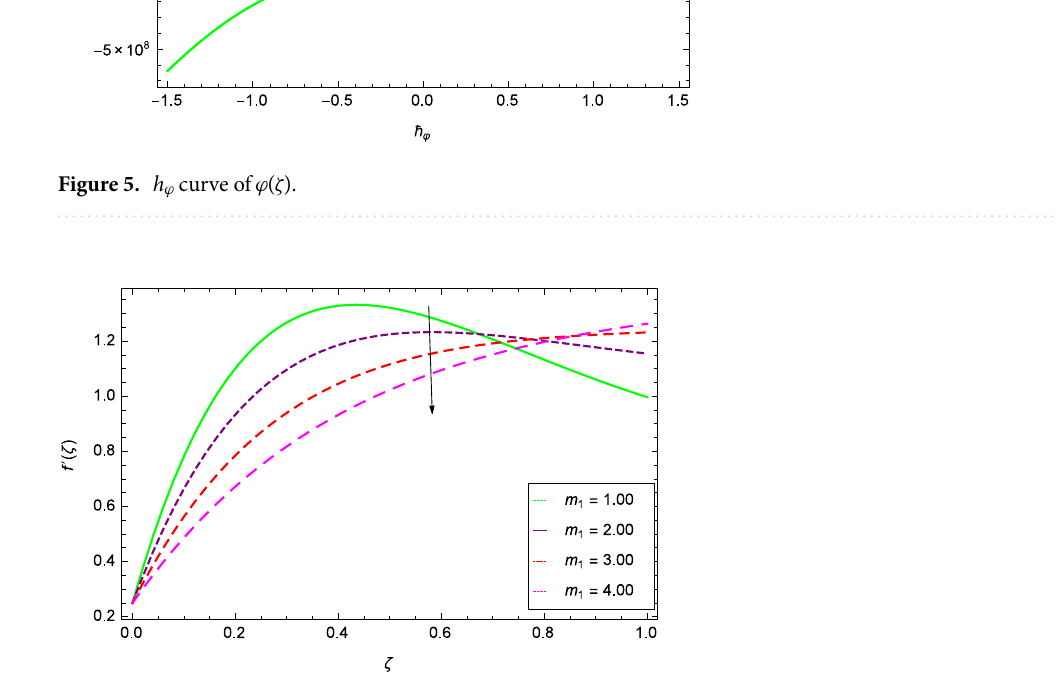
Figure 6. Parameter effect on velocity f ′ (ζ)